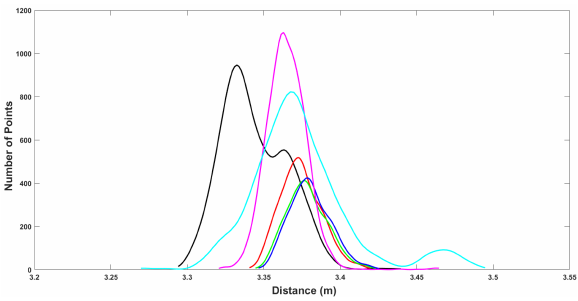
Figure 2. Variation of distance measurement with respect to different colors. The color of the plots corresponds to the surface color except cyan represent white color and magenta shiny silver